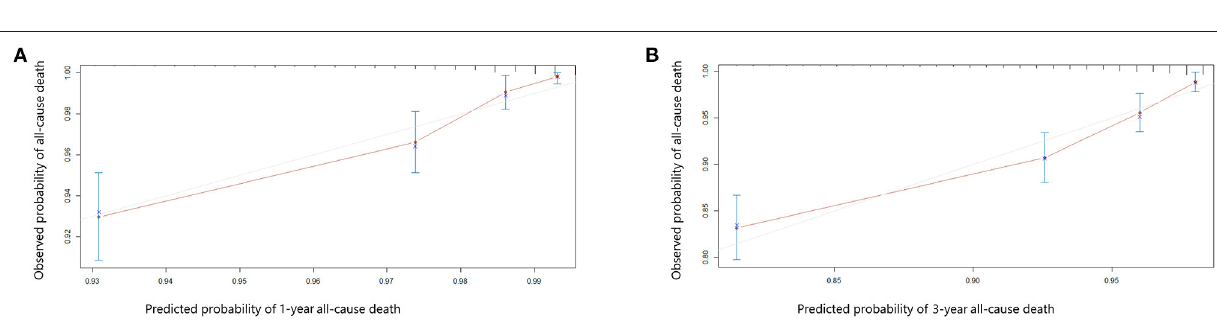
hs-CRP was decreased with higher eGFR (30). And